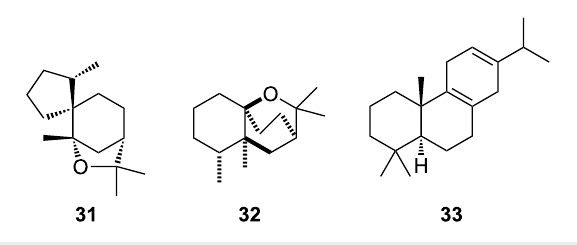
Figure 7: The revised ( 31 ) and the previously suggested ( 32 ) struc- ture of hypodoratoxide and the structure of miltiradiene ( 33 ).